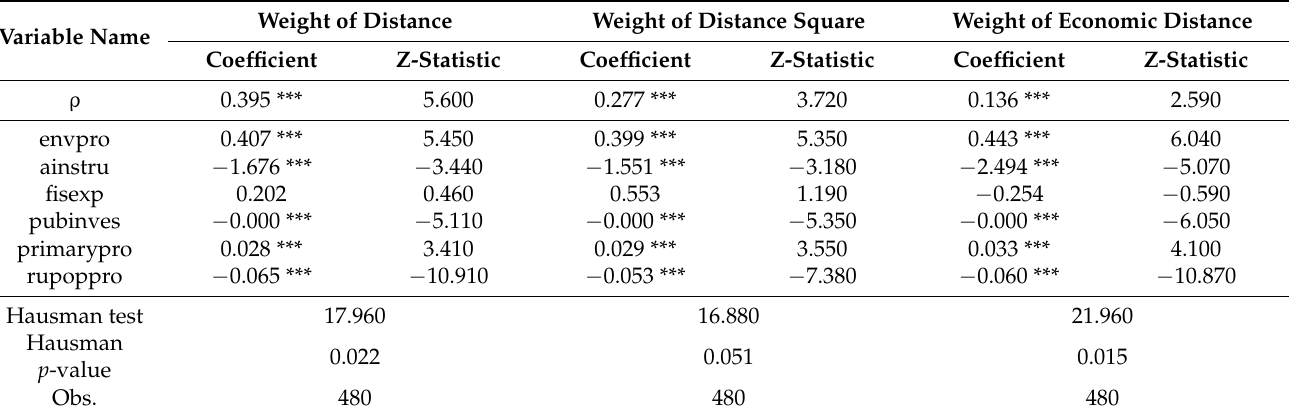
Table 4. Strategic interaction estimation of local governments’ carbon peak goals under different spatial weight